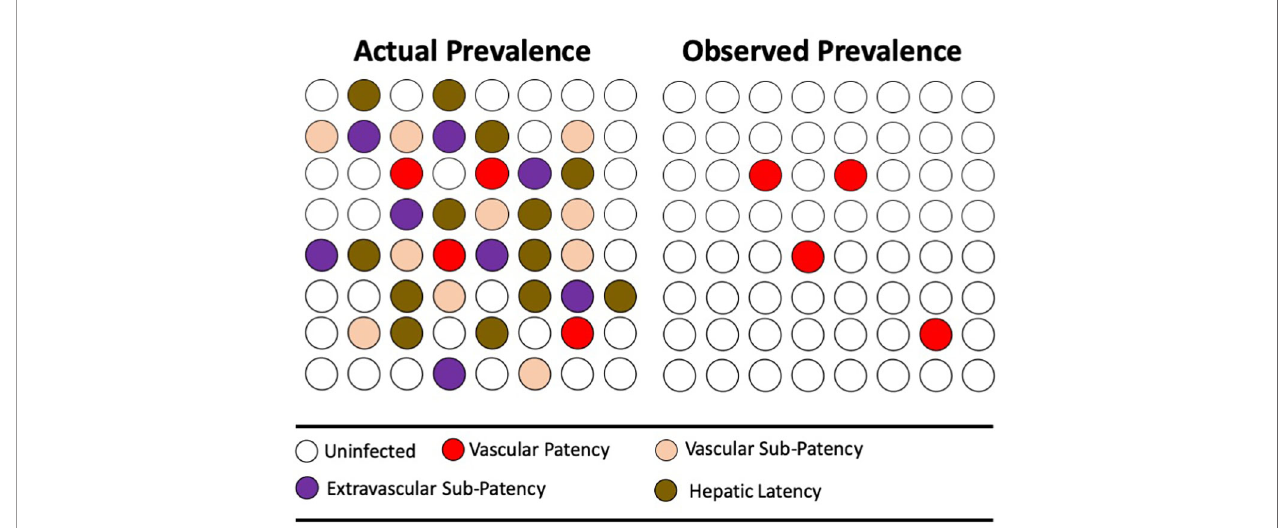
FIGURE 4 | The diagrams represent the same population of hypothetical individuals being either uninfected (no color) or infected (color). The colors represent varied states of infection, where mass screening for microscopic or antigen-capture patency of infection (red) reveals the minority thus infected. More sensitive PCR detection reveals otherwise sub-patent infection of blood, but not extravascular sequestration of active parasites or the inactive parasites of hepatic